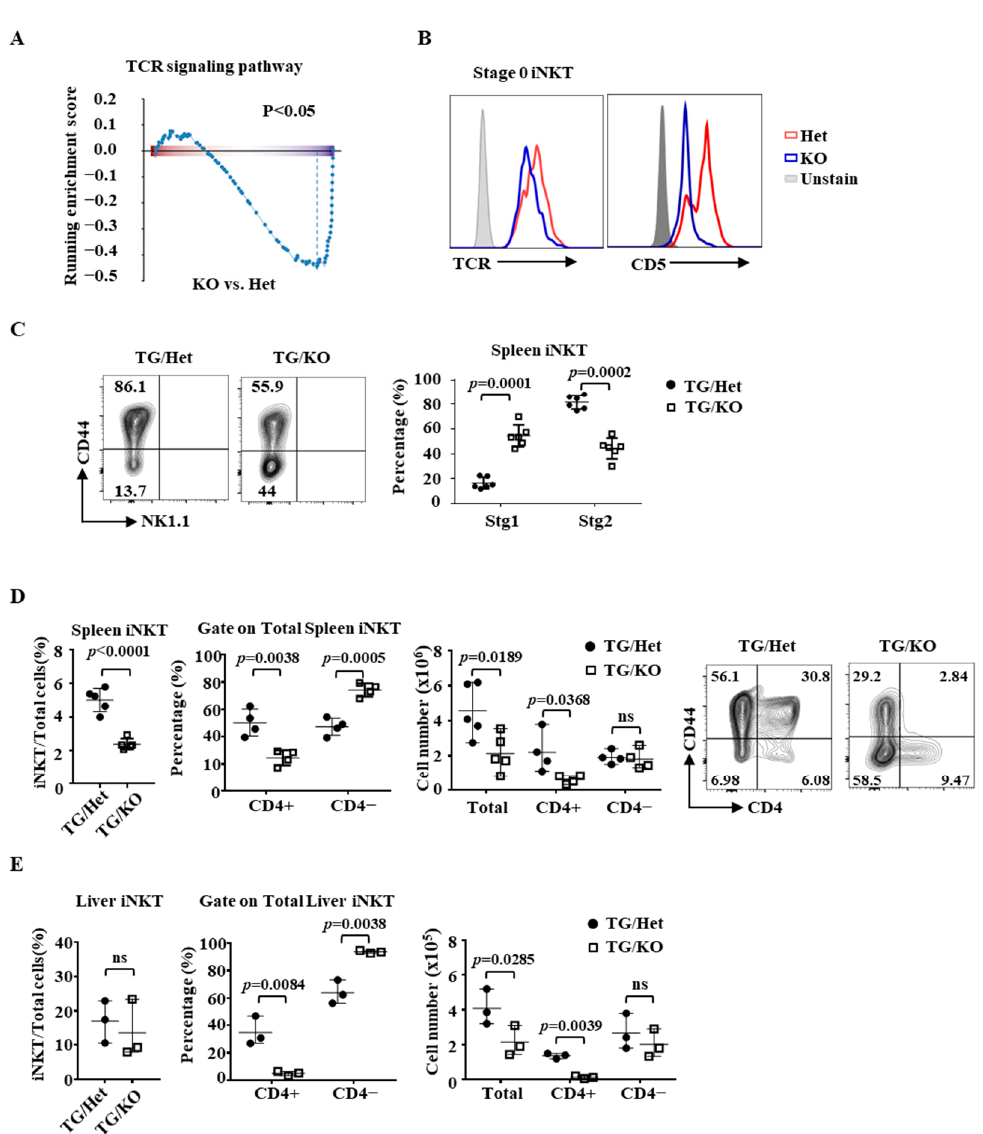
Figure 4. Partial rescue of the differentiation of Ets1KO iNKT cells with a V α 14J α 18 TCR transgene. ( A ) The result of GSEA analysis of the TCR signaling pathway is shown. ( B ) The surface level of TCR and CD5 in thymic iNKT cells of indicated genotypes was compared in the histogram. ( C ) Representative NK1.1/CD44 plots of splenic iNKT cells of indicated genotypes are shown. The percentages of stage 1 and stage 2 splenic iNKT cells from six pairs of TG/KO and TG/Het mice are shown in the right panel. ( D , E ) The percentage and absolute numbers of total, CD4+, and CD4 − iNKT cells in spleens ( D ) and livers ( E ) of indicated genotypes are shown. Representative CD4/CD44 FACS plots of splenic iNKT cells of indicated genotypes are also shown in ( D ).